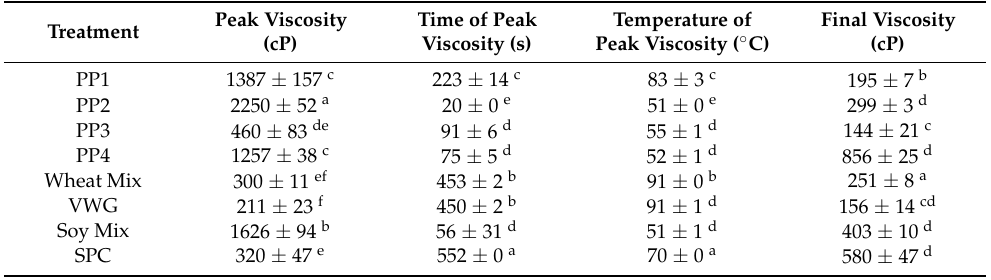
Table 7. Means and standard deviations of RVA-based rheological measurements. Means in a column followed by the same letter are not significantly different ( p <